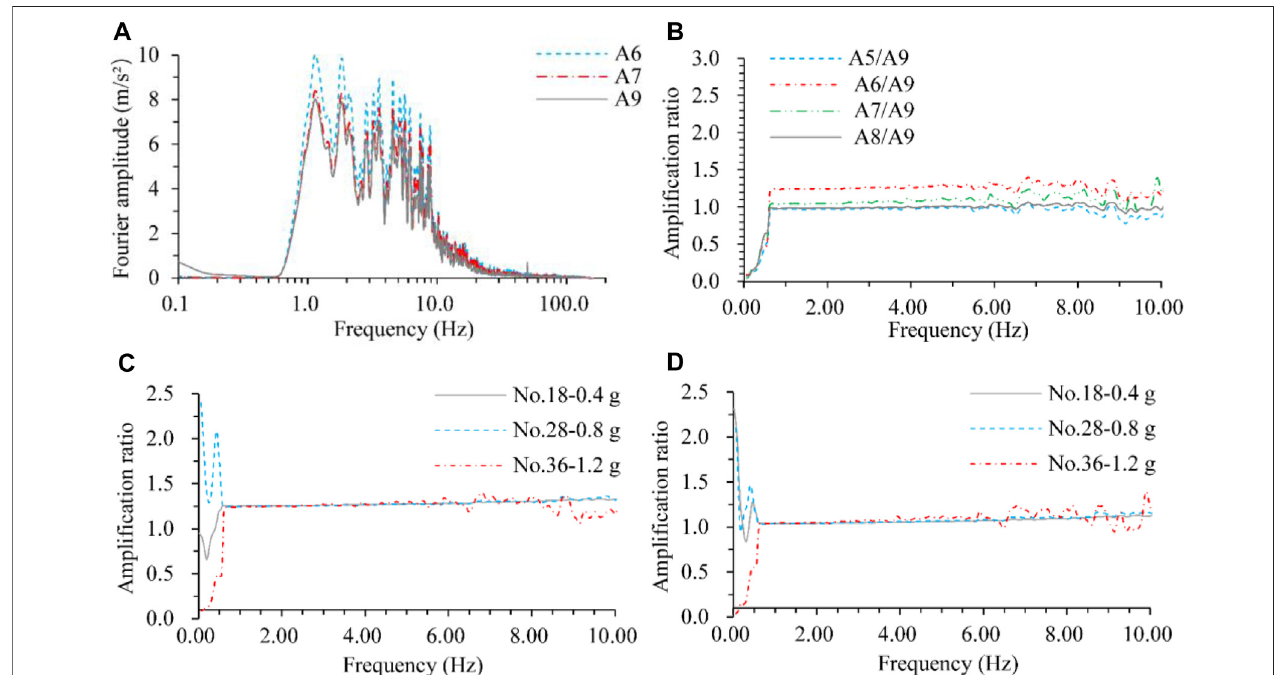
FIGURE 11 | Fourier spectrum and fault ampli fi cation ratio. (A) Fourier spectrum of speci fi c points at loading No.36 – 1.2 g, (B) Ampli fi cation ratio of Fourier spectrum at loading No.36 – 1.2 g, (C) Ampli fi cation ratio of Fourier spectrum at point A6, (D) Ampli fi cation ratio of Fourier spectrum at point A7.